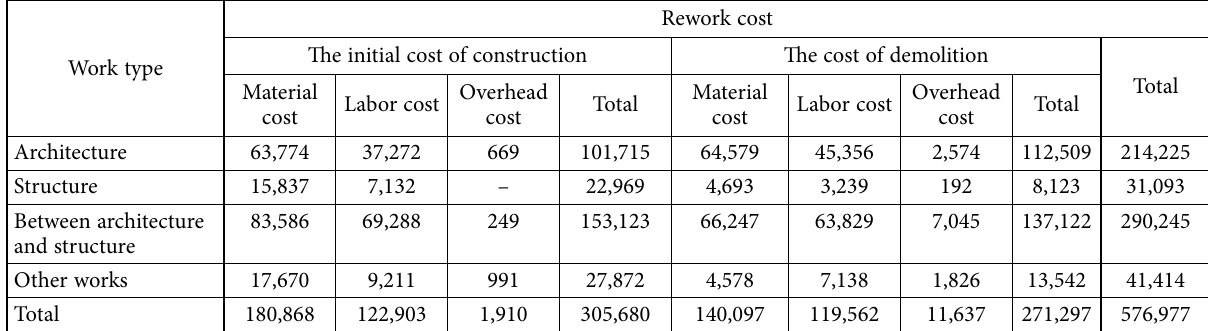
Table 6. Results of rework cost estimation (in USD)